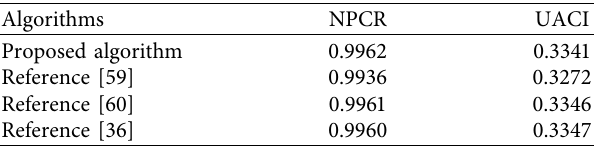
Figure 13: Test results of UACI ( N is the test group label). Table 7: NPCR and UACI results between the proposed algorithm and other schemes